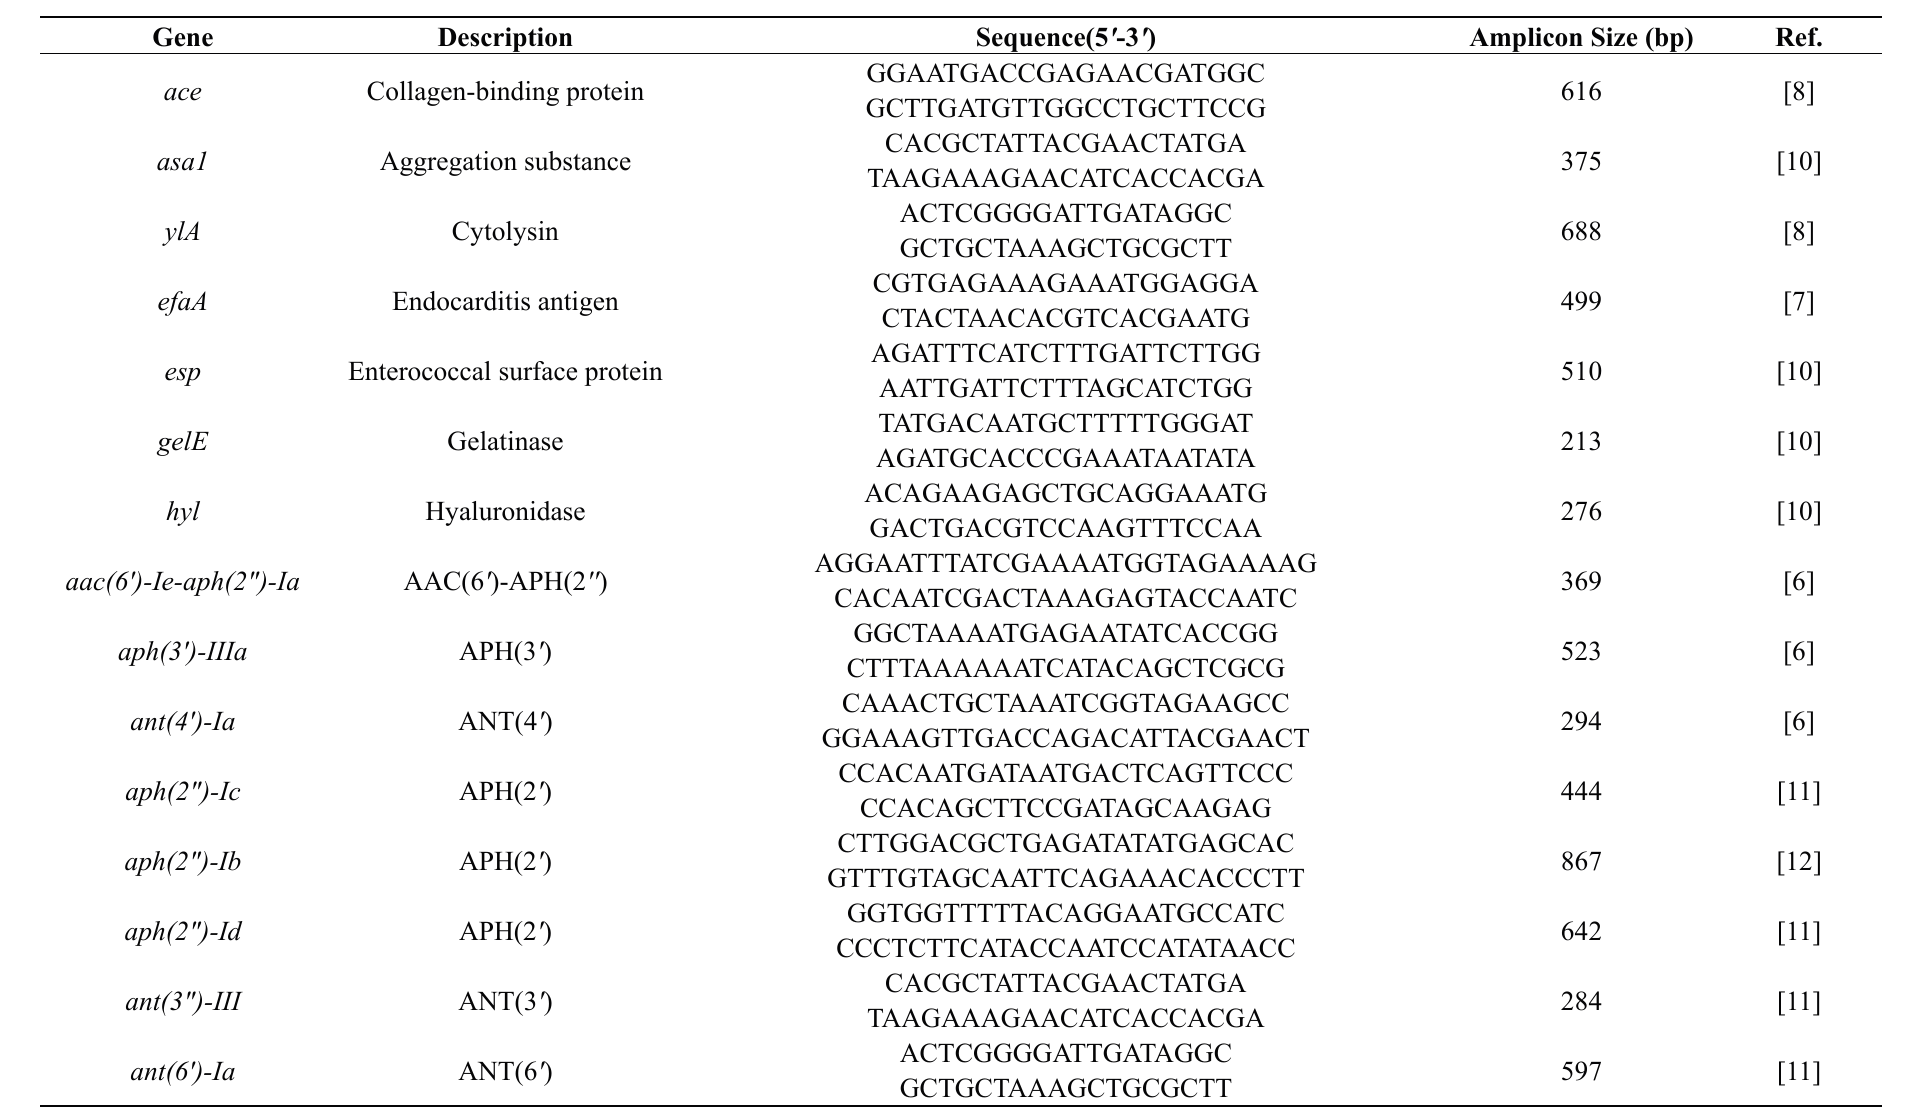
Table 1. PCR primers used in the amplification of virulence and resistance